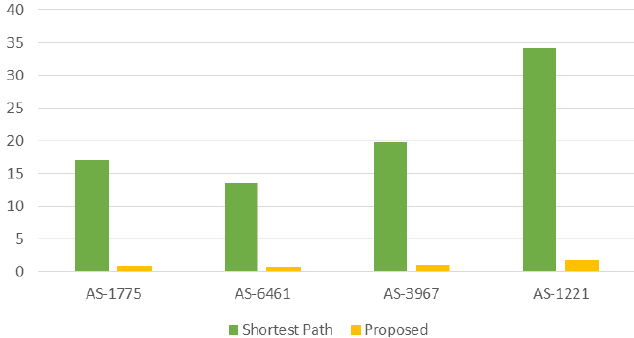
Figure 12. Comparison in traffic for routing (MB). The traffic used for the proposed work is much smaller than shortest path , which is about 6–8% of the traffic of the shortest path